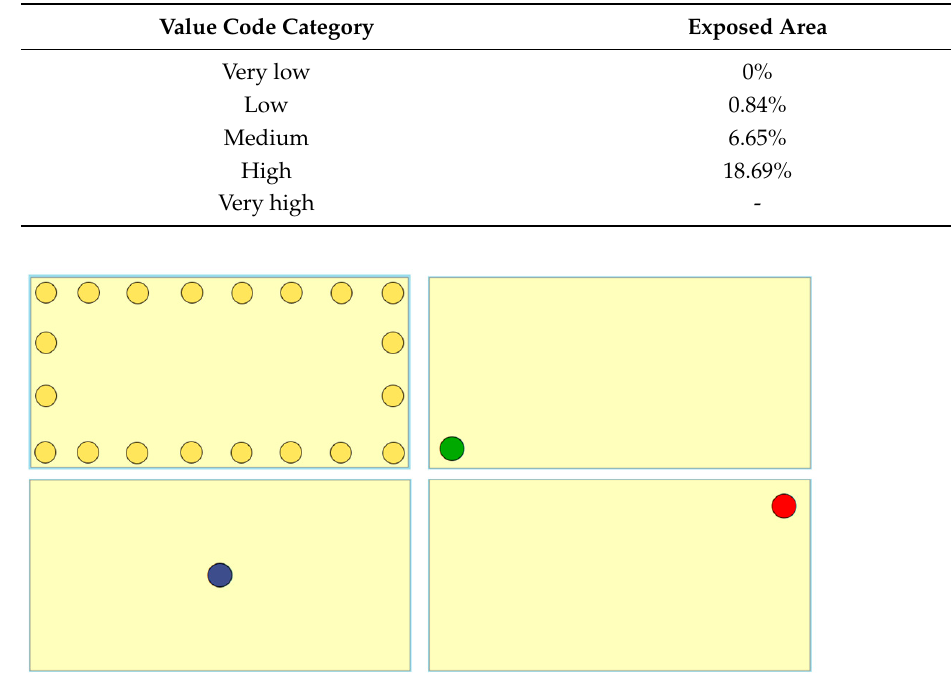
Figure 5. Possible positions of a source within a rectangle as input assumption for an assessment.